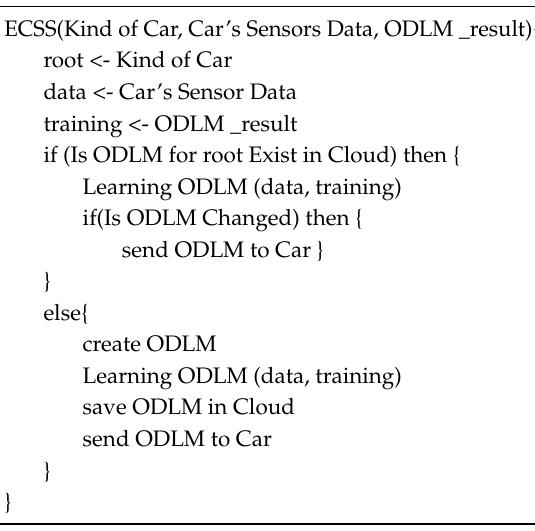
Algorithm 2. Algorithm of the